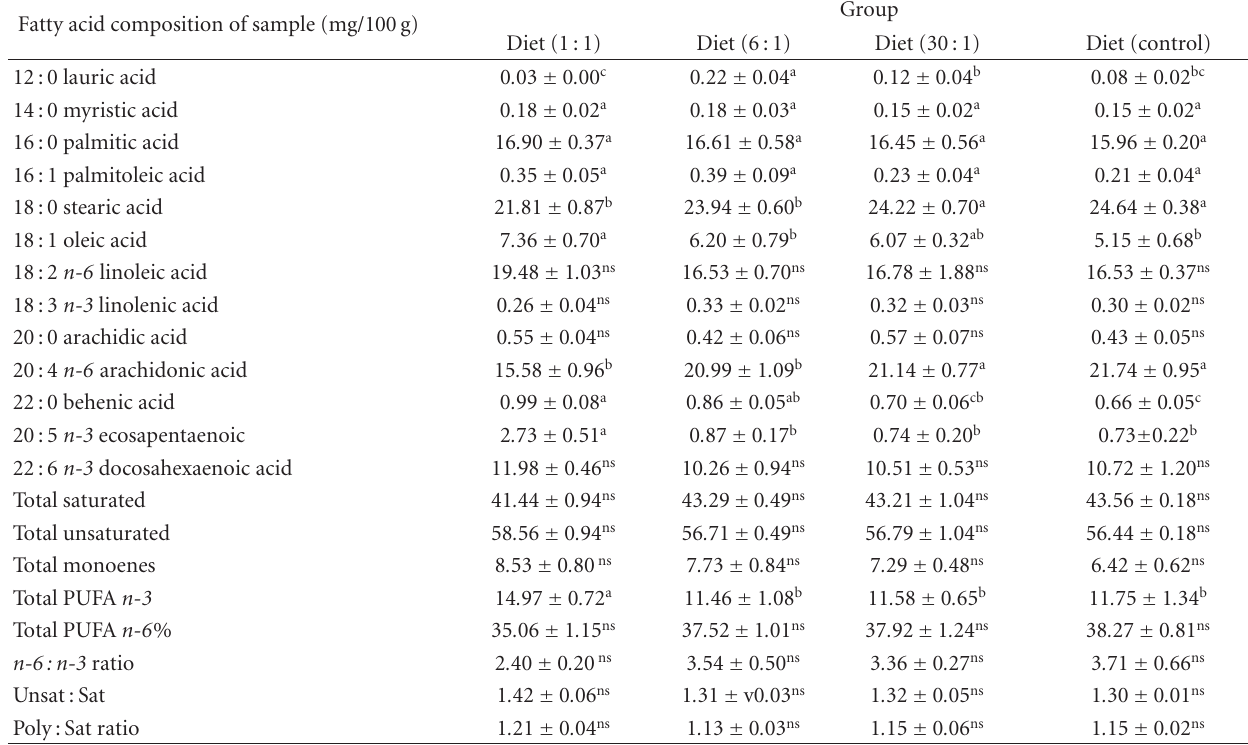
Table 3: Liver tissue fatty acid composition (mg/100 mL; Mean ± SE; n = 7) of rats from di ff rent treatment groups after 10 weeks of feeding. Fatty acid composition of sample